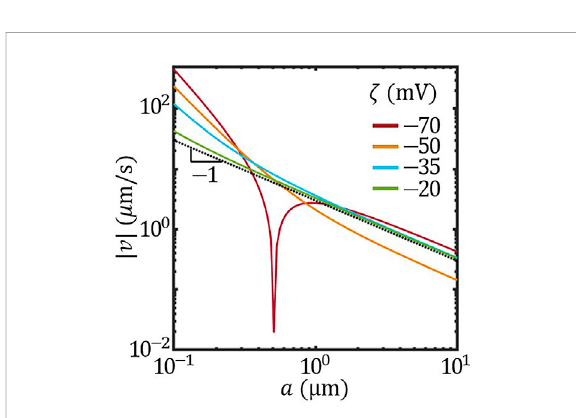
FIGURE 5 The size-dependent speed of Janus colloids with different overall ζ potential (solid lines). Dotted black line plots | v | ∝ 1/ a